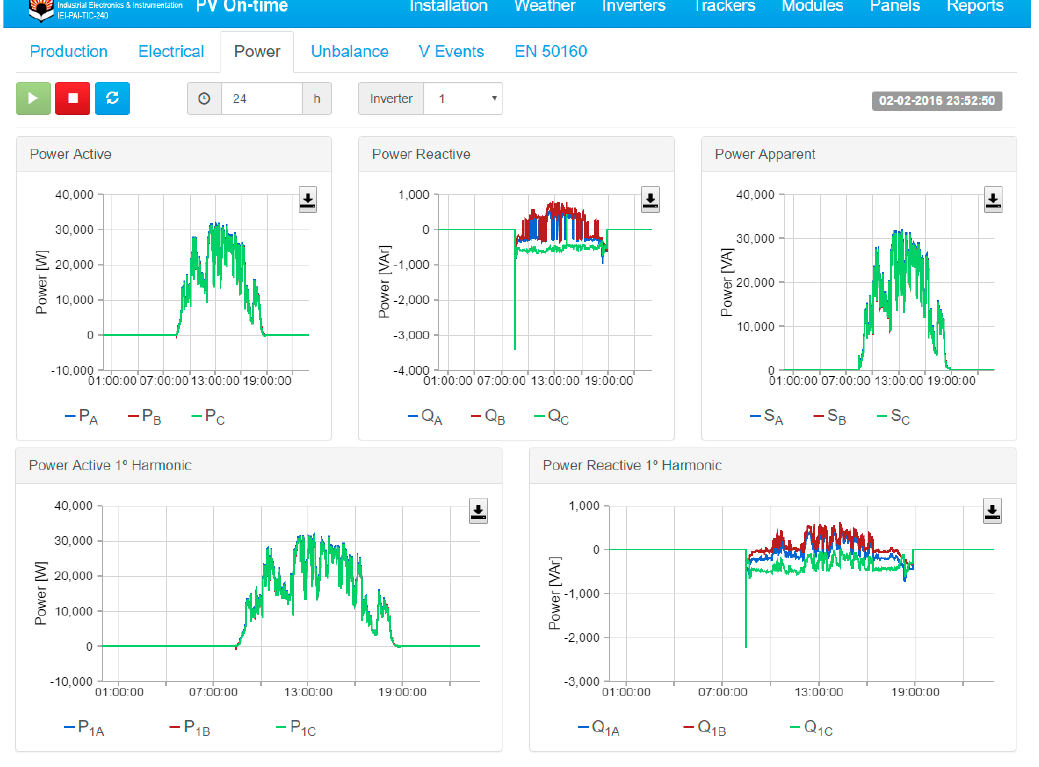
Figure 18. On-line monitoring application for supervising the PV plant in